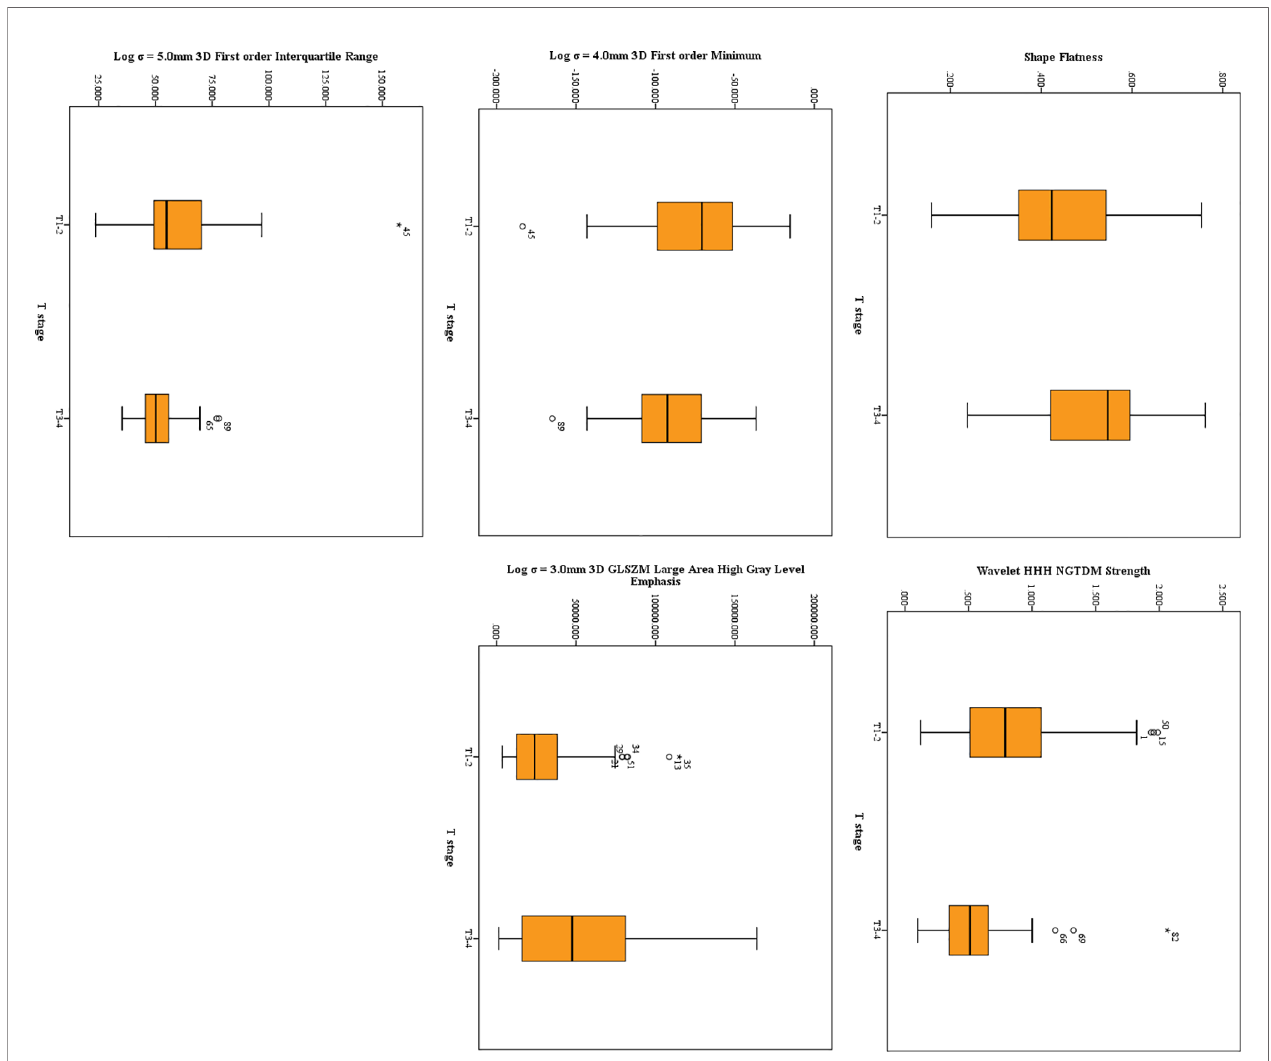
FIGURE 3 | The distribution of signi fi cant features derived from HR-T2WI. The symbol ( “ * ” ) represents the extreme